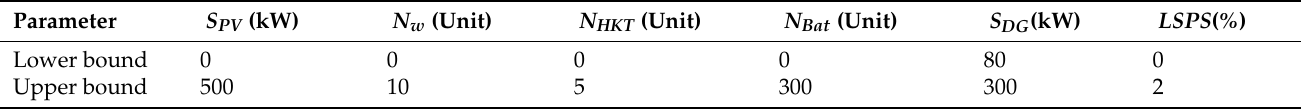
Table 2. Optimization parameters and constraints used in the case